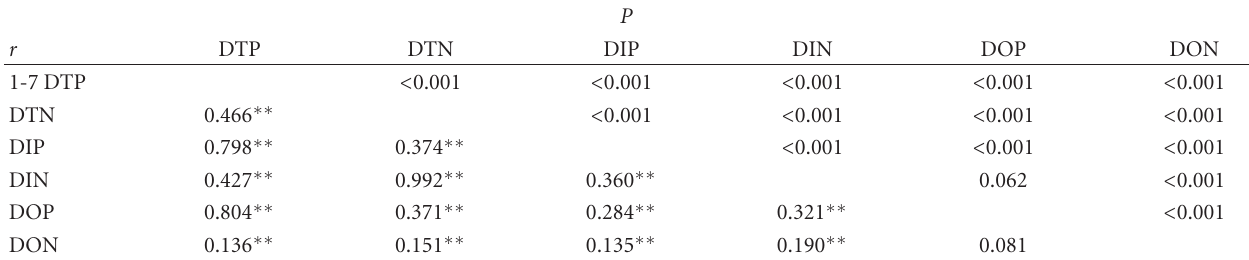
Table 2: Relationships between the di ff erent forms of N and P.